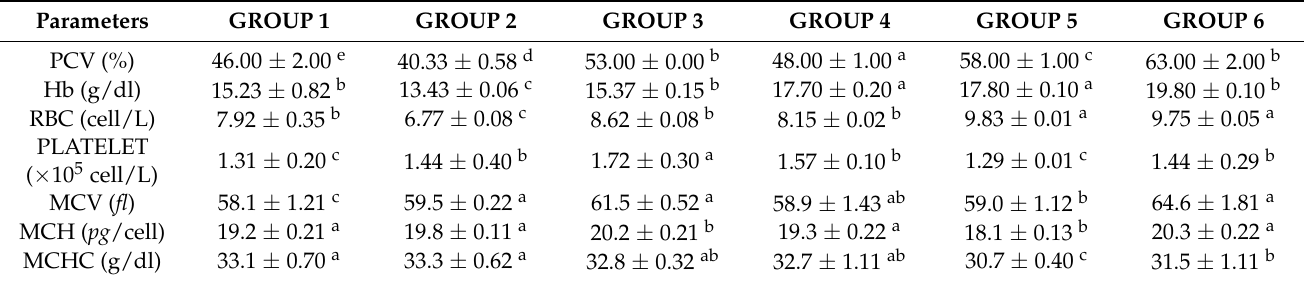
Values are expressed as mean ± S.D ( n = 3). Mean with similar superscript on the same column are not significantly different ( p < 0.05). Hb: hemoglobin, RBC: red blood cell, MCV: mean corpuscular volume, MCH: mean corpuscular haemoglobin, MCHC: mean corpuscular hemoglobin concentration. Group 1: normal control, Group 2: venom control, Group 3: envenomed rats treated with 0.2 mL of polyvalent antivenom, Group 4: envenomed rats treated with 200 mg/kg − 1 of the extract, Group 5: envenomed rats treated with 400 mg/kg − 1 of the extract, Group 6: envenomed rats treated with 600 mg/kg − 1 of the